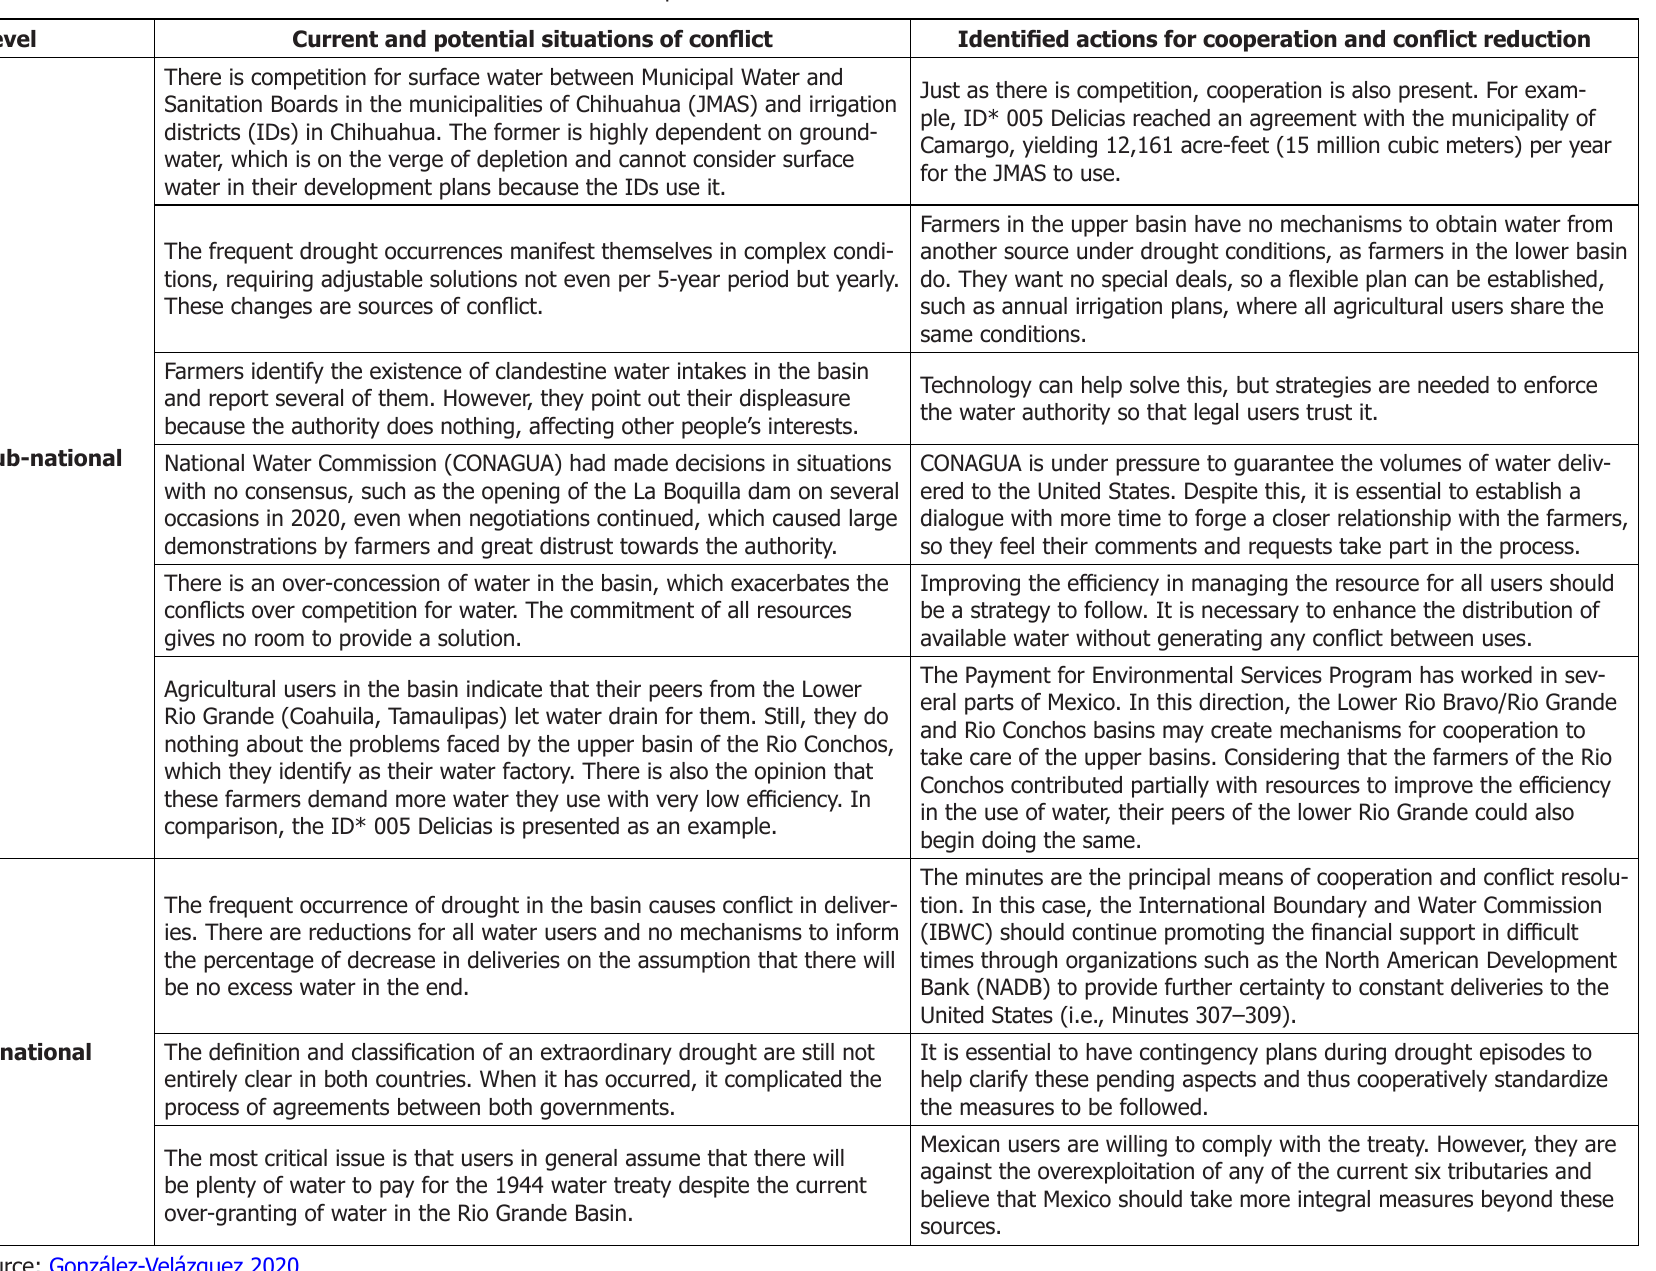
Table 8. Rio Conchos Watershed conflict situations and actions of cooperation at the sub-national and binational levels.